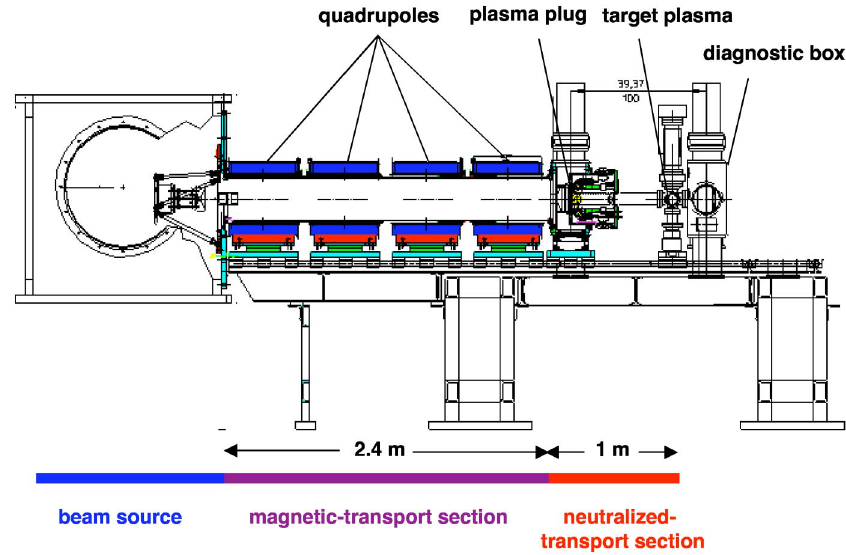
FIG. 2. (Color) Plan view of the NTX injector, magnetic transport, and neutralized-transport sections. The Marx generator, located to the side of the experiment, is not